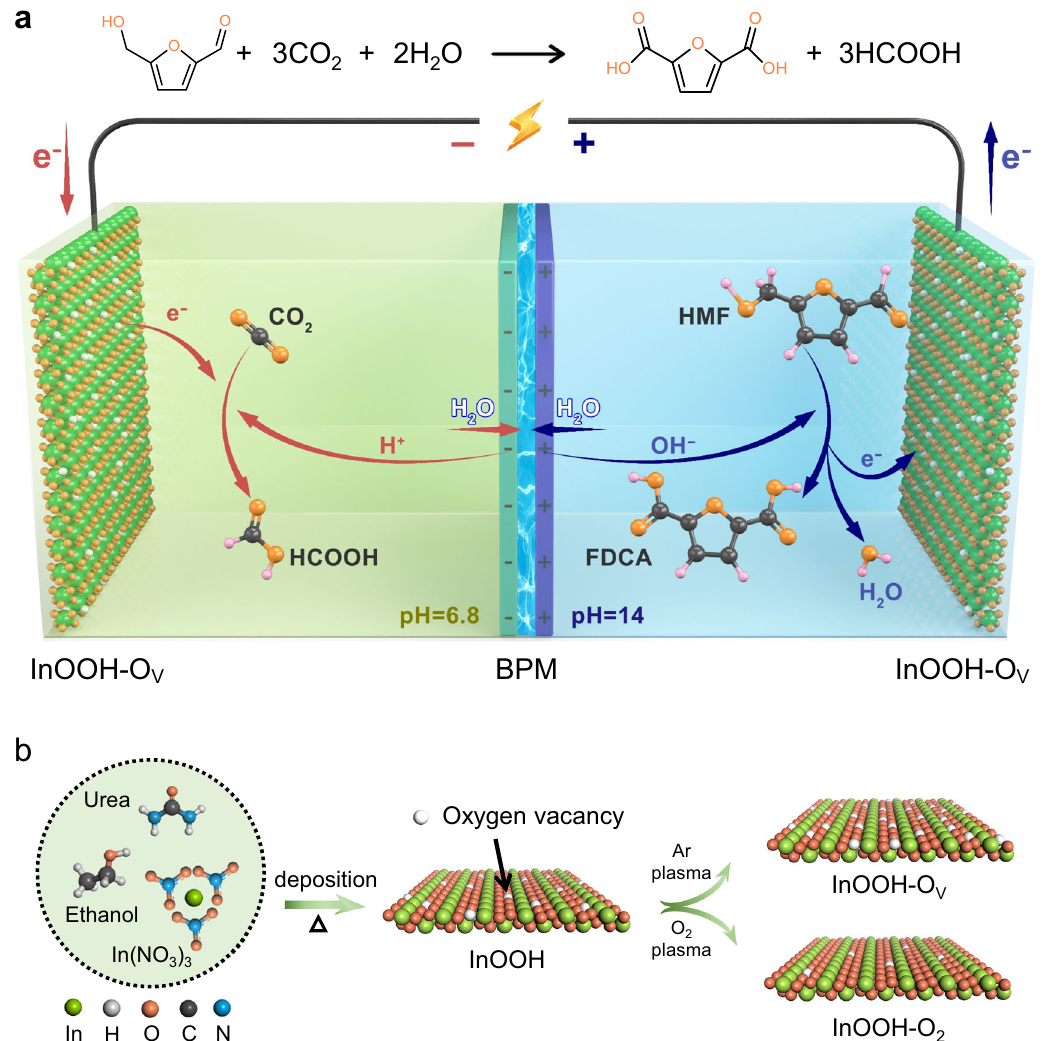
Fig. 1 | Schematic illustration. a Integrated electrolysis cell coupling CO 2 RR with HMFOR. b Synthetic processes of InOOH, InOOH-O V , and InOOH-O 2